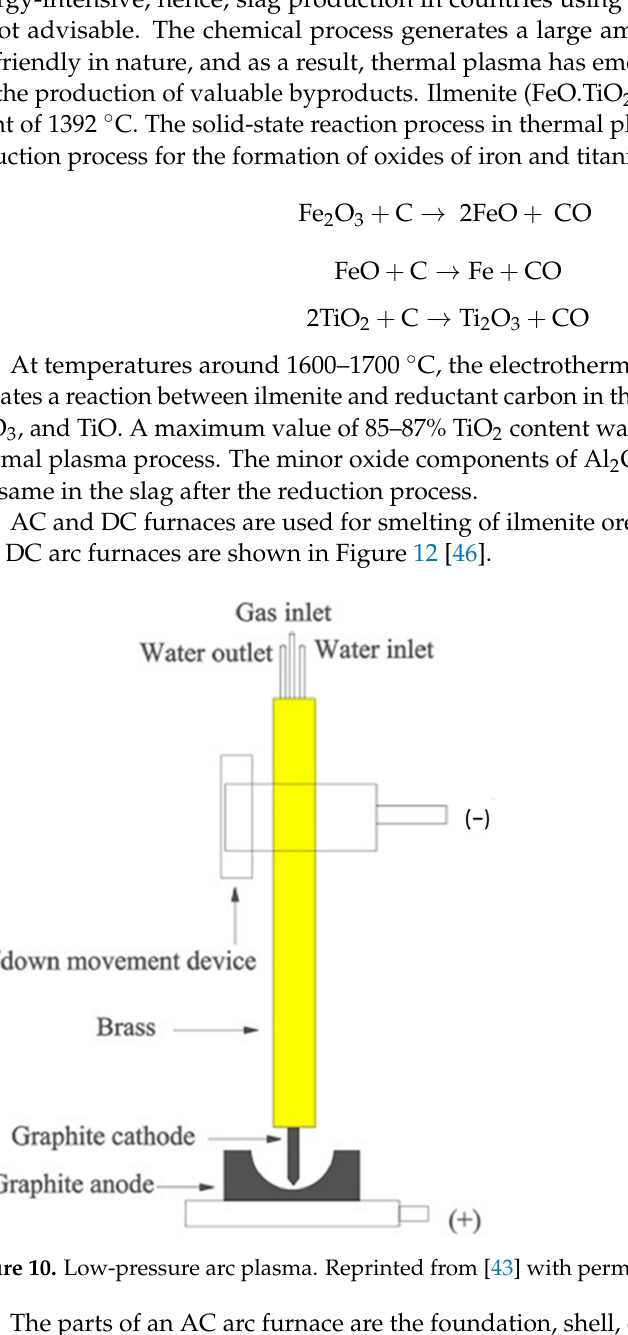
Figure 11. A schematic diagram of a two-torch plasma furnace withdrawing an ingot. Reprinted from [39] with permission from Elsevier 1994.